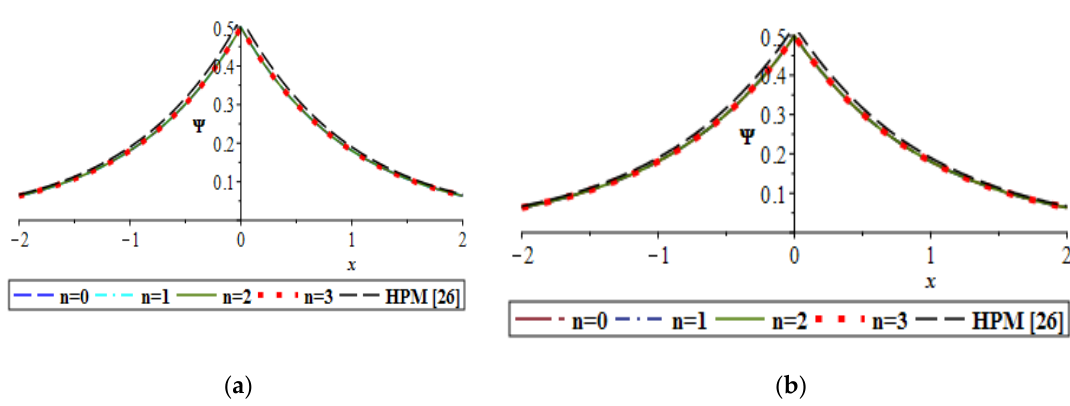
Figure 4. Comparison plots of